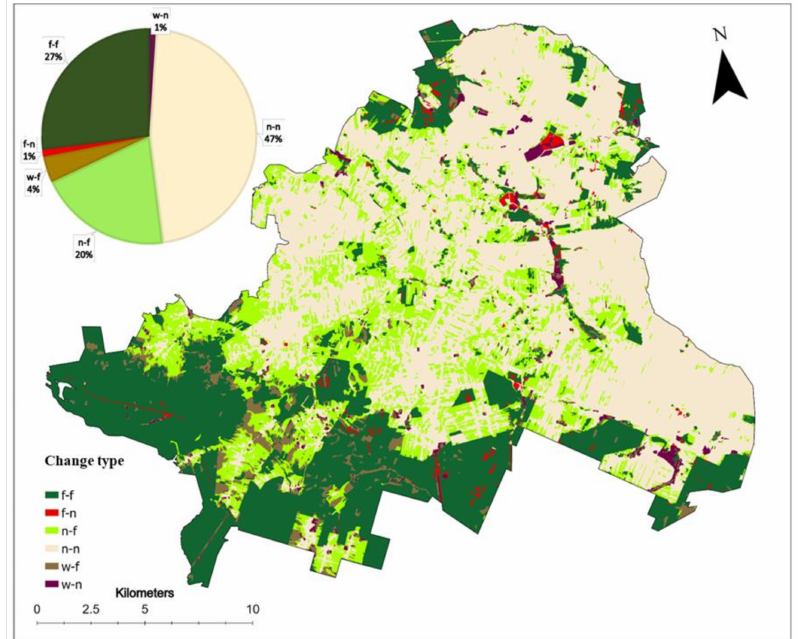
Figure 4. 1970–2018 land cover change map and share of land cover change types in the Szydłowiec county. “f” represents forest, “n” represents non-forest, and “w” represents wooded